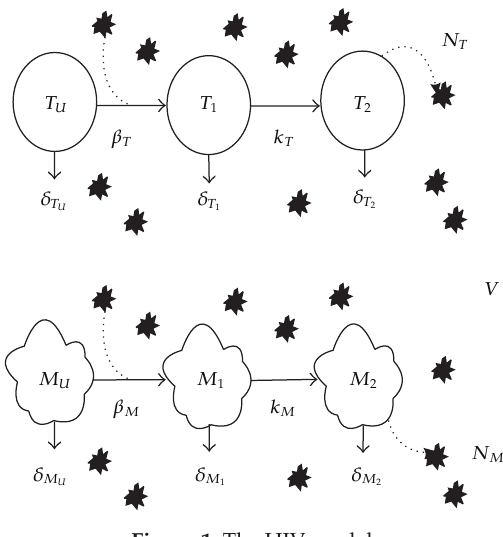
Figure 1: The HIV